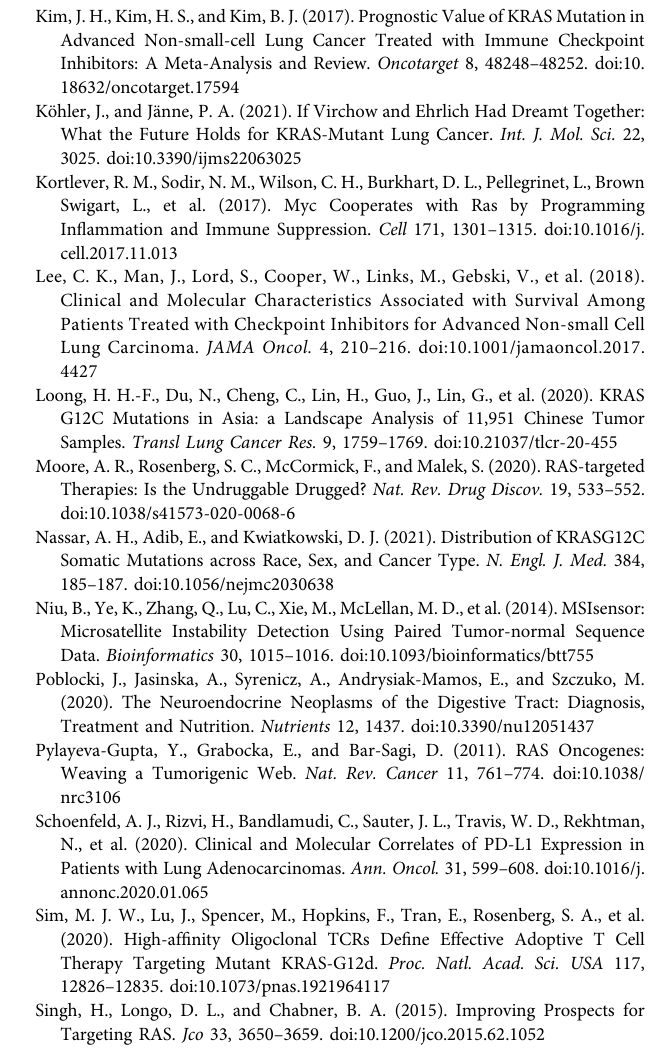
Supplementary Table S1 | Top 20 mutant genes of all rare tumor